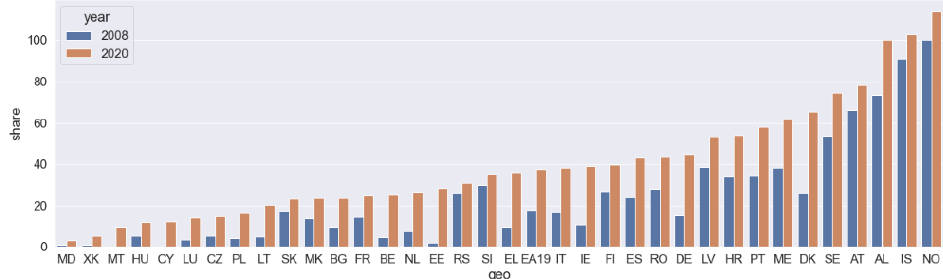
Figure 8. Share of renewable energy sources on electricity consumption in 2008 and 2020 in European economies, Source dataset: Eurostat: NRG_IND_REN.